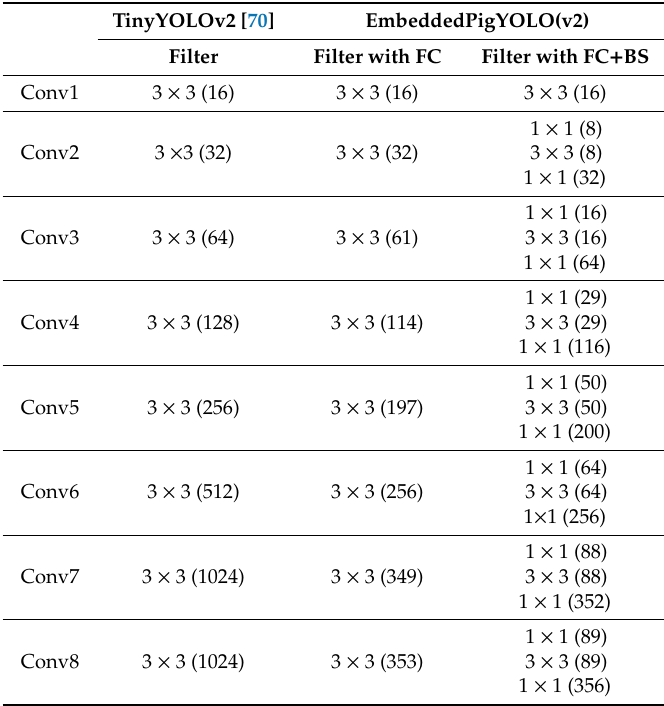
Table 2. Comparison between TinyYOLOv2 [74] and EmbeddedPigYOLO(v2) with pig data set.